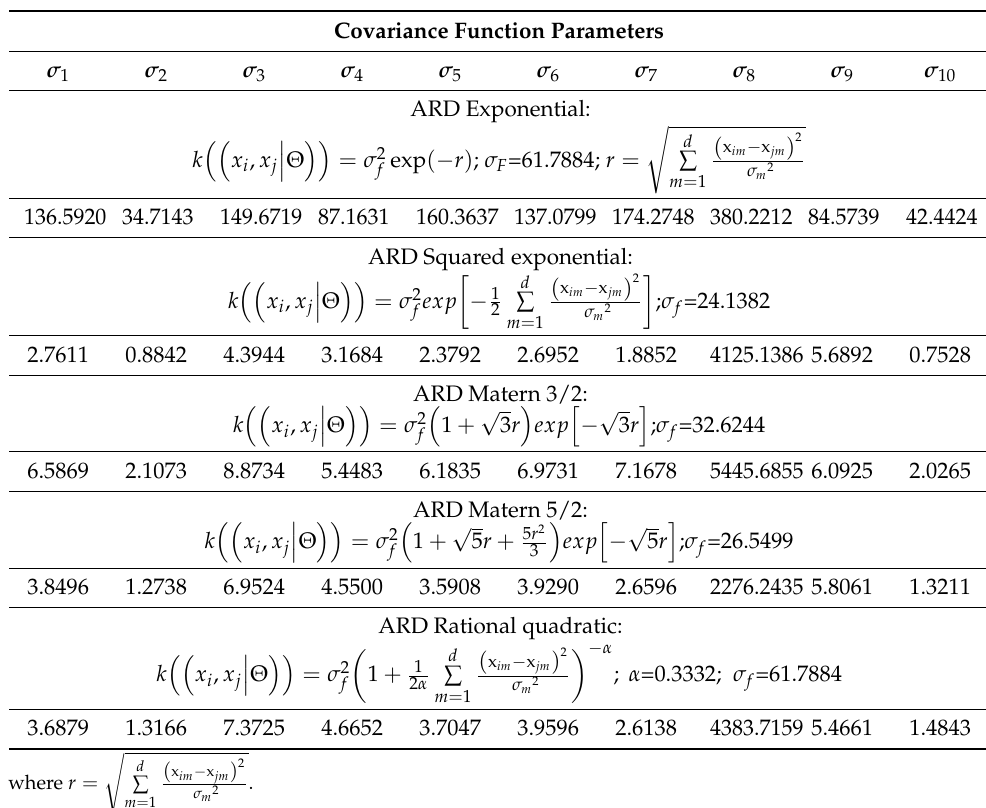
Table 8. Parameters of GPR ARD model covariance